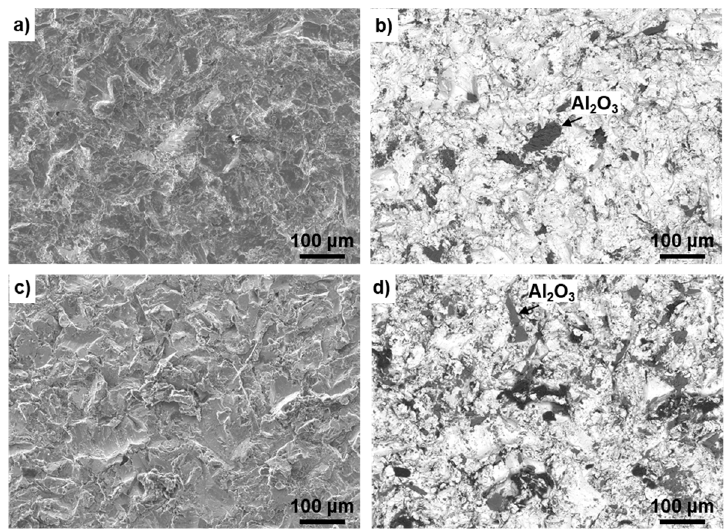
Figure 8. SEM images of grit-blasted surfaces. ( a , b ) Ti–15–4 alloy surface blasted with 24-grit Fuji Random WA Al 2 O 3 particles, ( c , d ) Alloclassic stem surfaces blasted with 24-grit corundum Al 2 O 3 particles, ( a , c ) secondary electron images, and ( b , d ) reflected electron images.